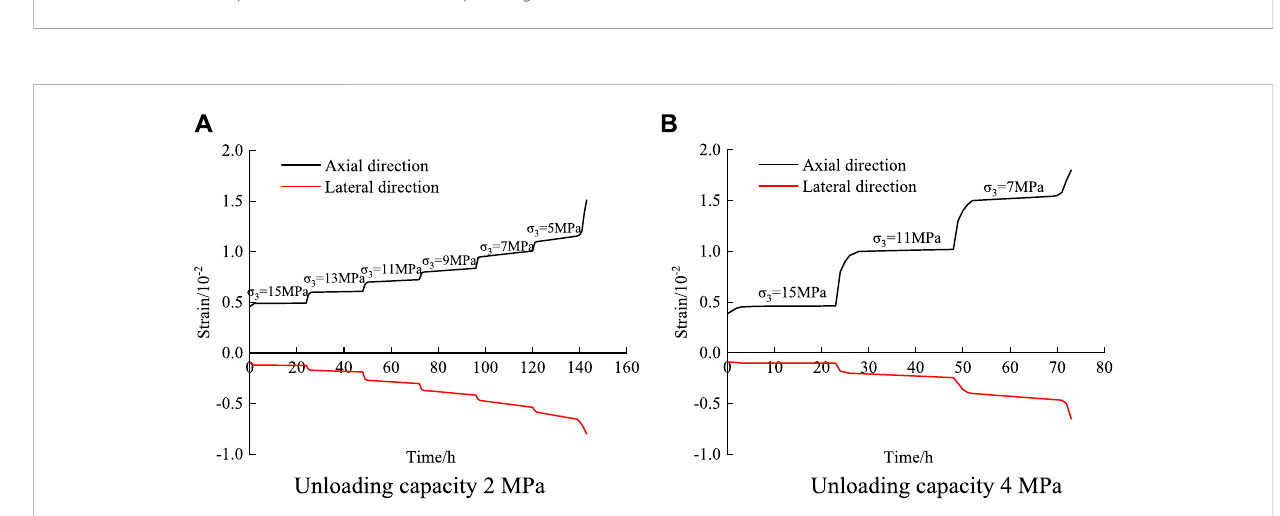
FIGURE 4 RLW-2000 Microcomputer controlled triaxial creep testing machine.